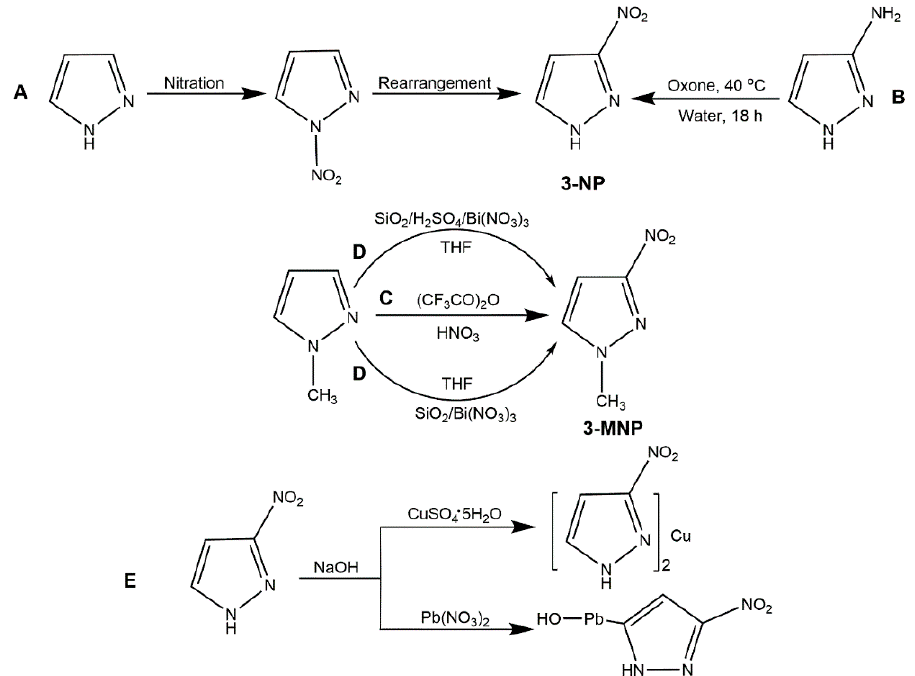
Figure 1. Summary of synthesis of 3-NP, 3-MNP and metal salts of 3-NP.